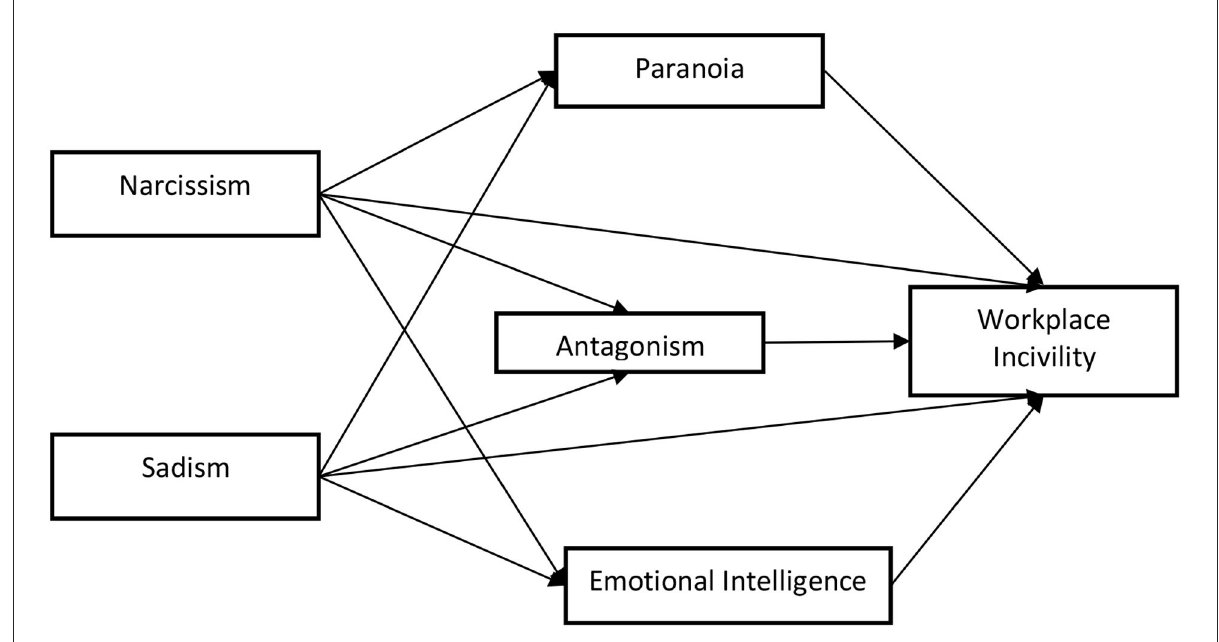
FIGURE1 Theoretical framework.